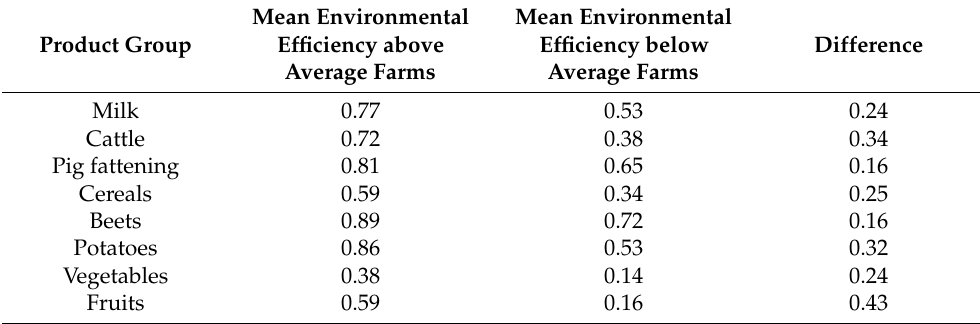
Table 4. Potential for improvement if below average environmental efficient farms achieve average environmental efficiency of above-average